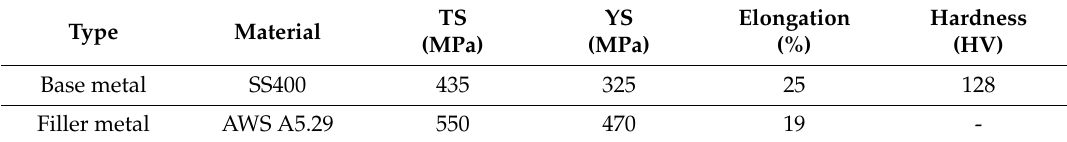
Table 1. Mechanical properties of the base metal and filler metal used.